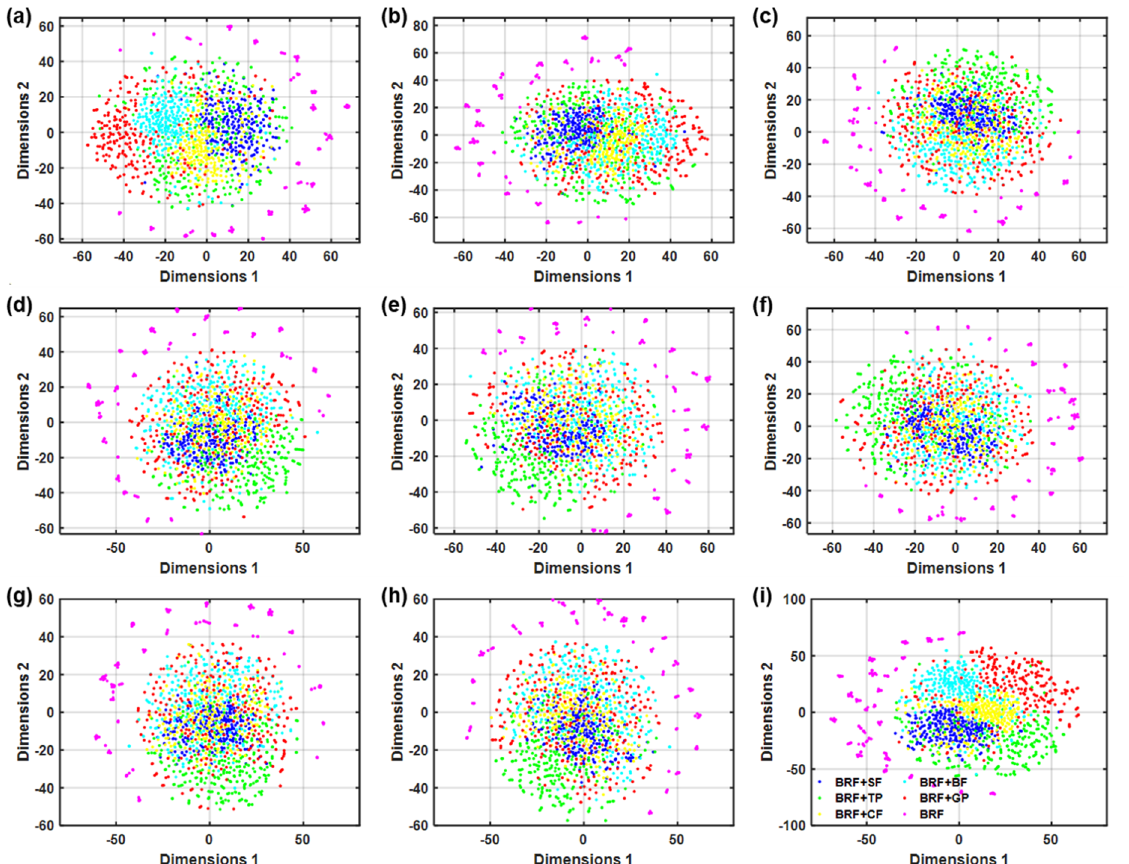
Figure 6. Results of t−SNE visualization based on spectra under ( a ) 1, ( b ) 1.5, ( c ) 2, ( d ) 2.5, ( e ) 3, ( f ) 3.5, ( g ) 4 and ( h ) 4.5 μs and ( i ) time−resolved spectra.